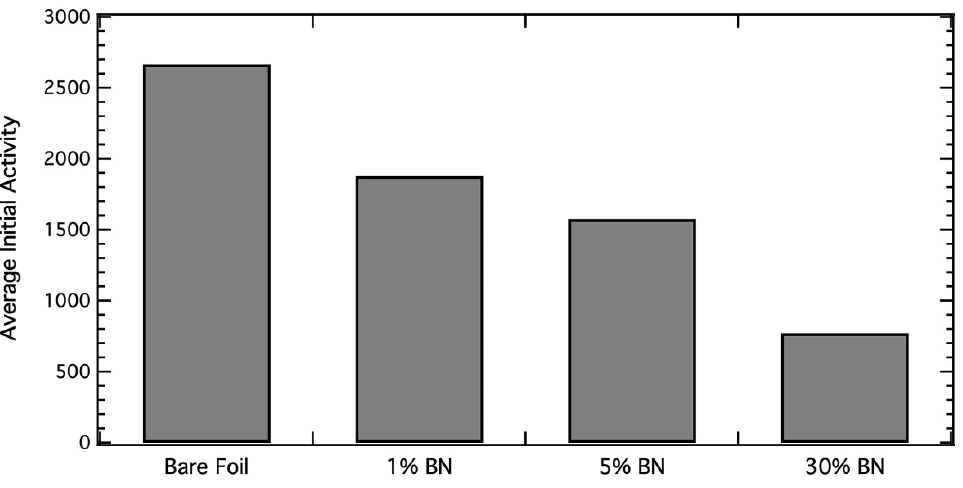
Figure 3. Average initial radiation activity. Reprinted from [72], with permission from Elsevier.